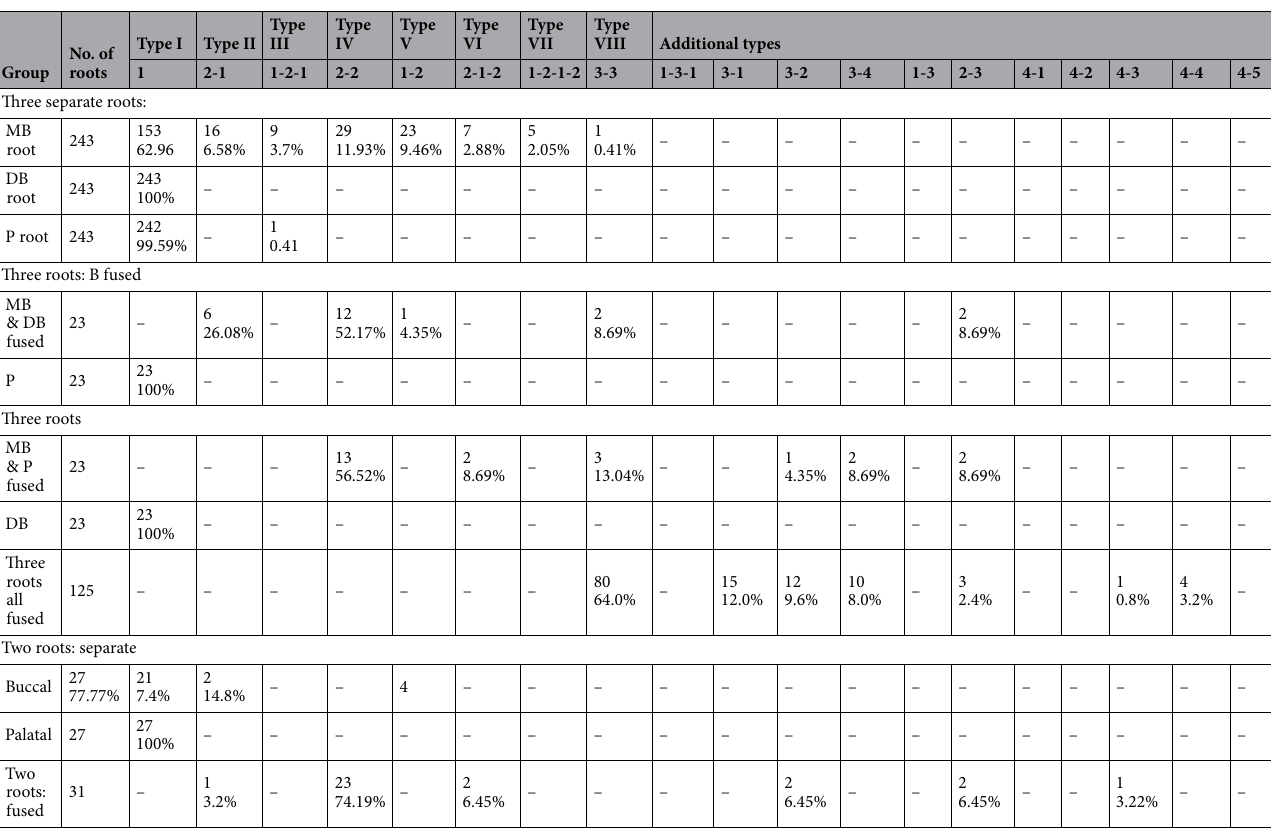
Table 3. Number and percentage of the common canal system types in maxillary third